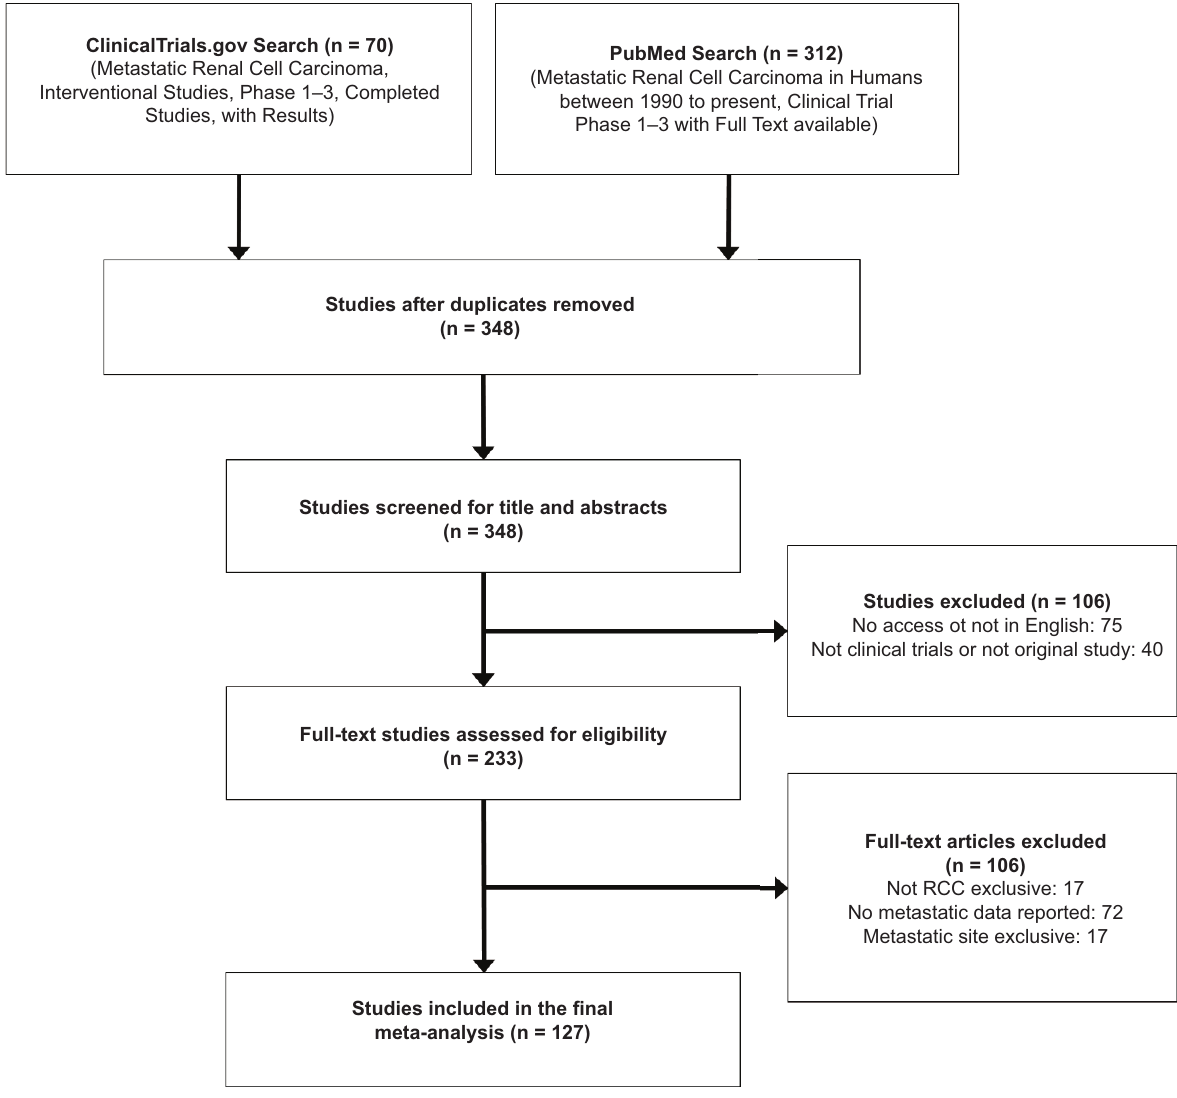
Figure 1: Study selection flow